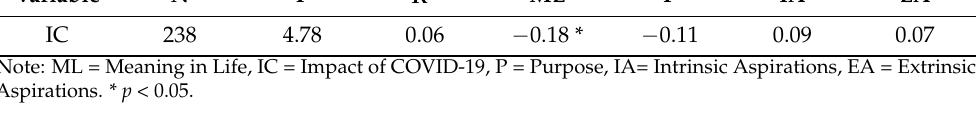
Table 3. Regression analyses of the relationships between meaning in life, its predictors and the impact of COVID-19 related stress. Variable N R